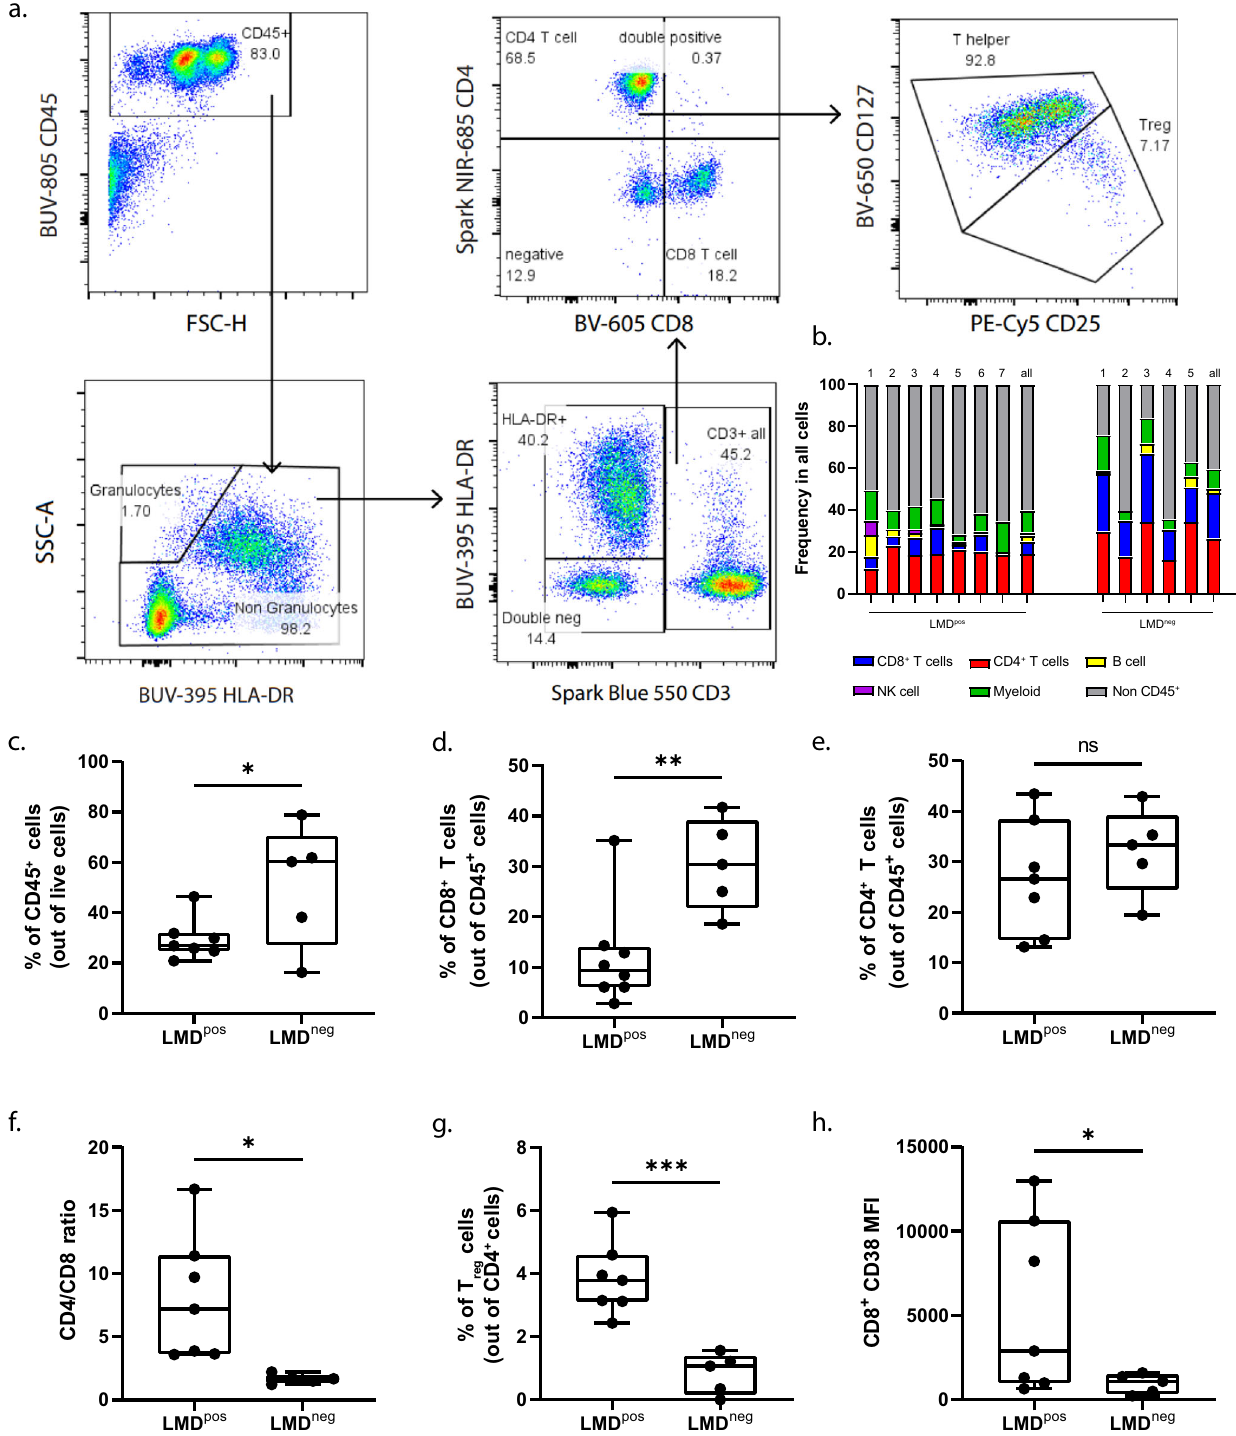
Fig. 2 Decreased frequencies of CD8 + T cell populations in the CSF of patients with leptomeningeal disease. a Gating strategy to identify leukocyte frequencies pre-gated from singlets and live populations in CSF. b Frequency plot in all cells of each individual patient and cumulative mean (all) comparing LMD pos (left columns) and LMD neg (right columns) in CSF. c – e Box plots comparing the frequency of immune cells between LMD pos vs. LMD neg by the following immune cell types: c CD45 + cells, d CD8 + T cells, and e CD4 + T cells. f CD4/CD8 T cell ratios and g frequency of T reg . (T reg populations were de fi ned as CD4 + CD25 + CD127 lo ). h Median fl uorescent intensity of CD38 expression on CD8 + T cells. For box plots in this fi gure, the boxes indicate the interquartile range, while the lower and upper bars correspond to the minimum and maximum non-outlier values of the data distribution. Centerline indicates the median value. Statistical signi fi cance was assessed in c – h by unpaired student t test. (* or **) indicates statistical signi fi cance with p < 0.05, p < 0.01 respectively. n.s not signi fi cant.